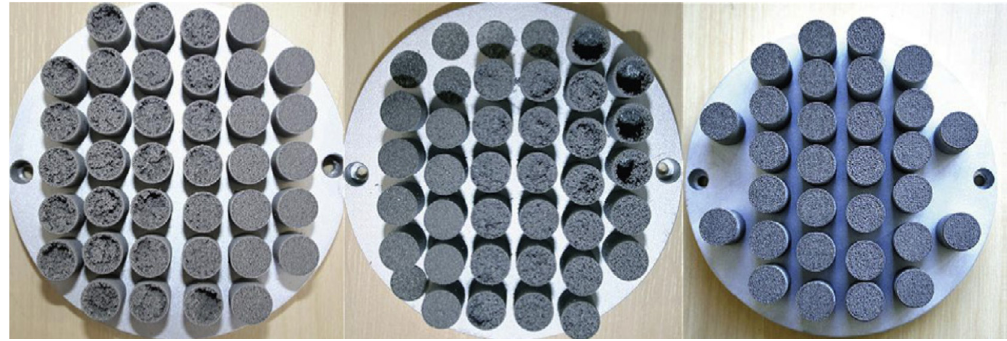
Figure 2. Additively manufactured porous wick samples [12].